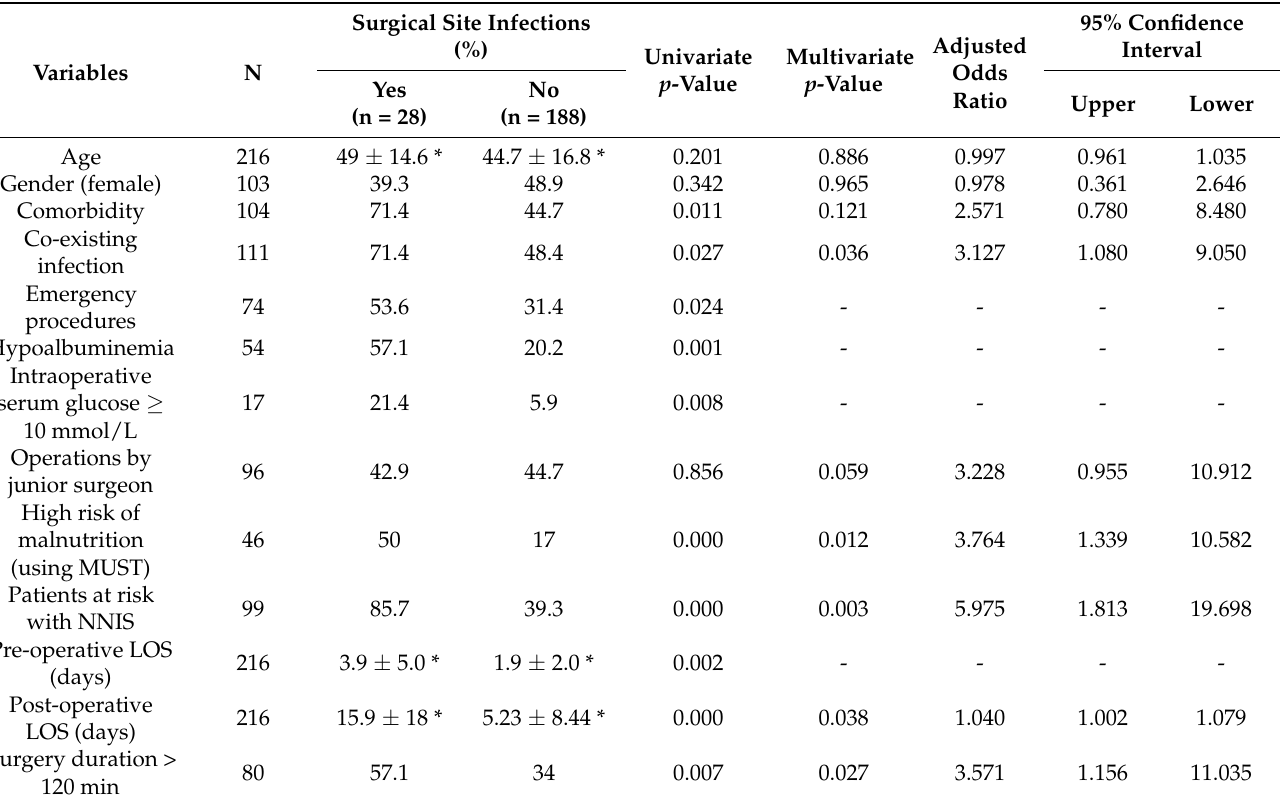
Table 4. Multivariate analysis of the data reveals independent predictors of SSI in the current surgical